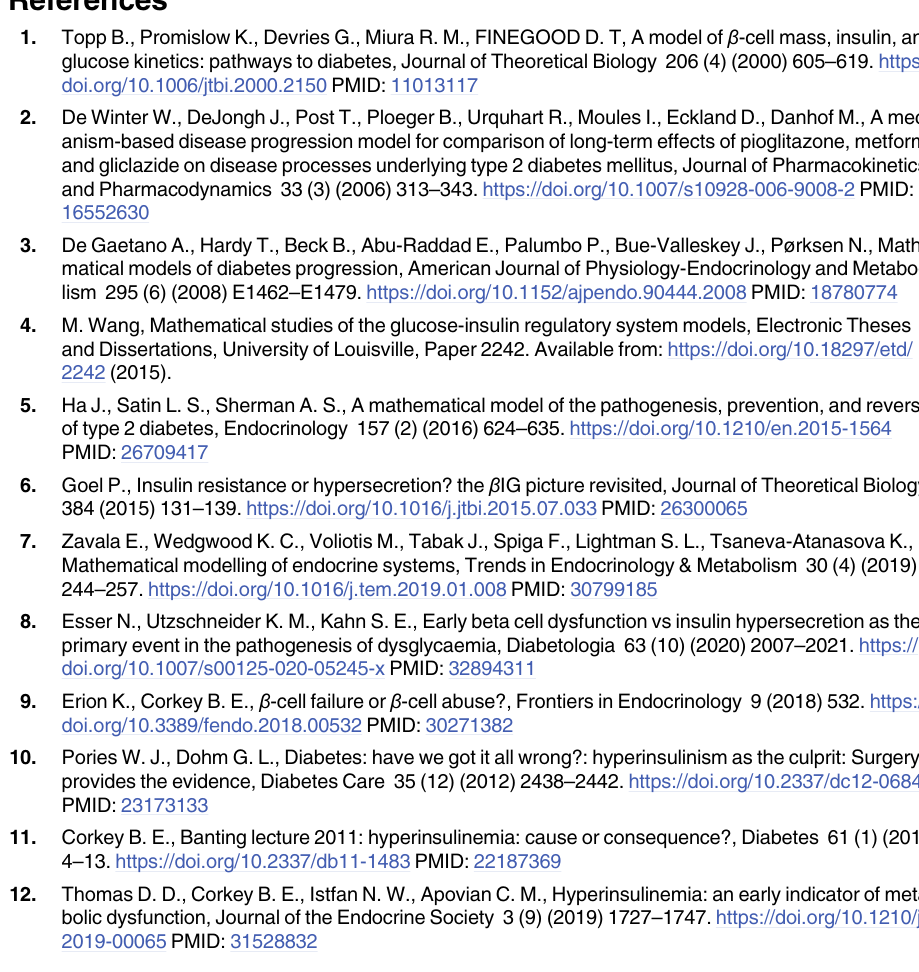
on the severity of factor X and diabetes 1